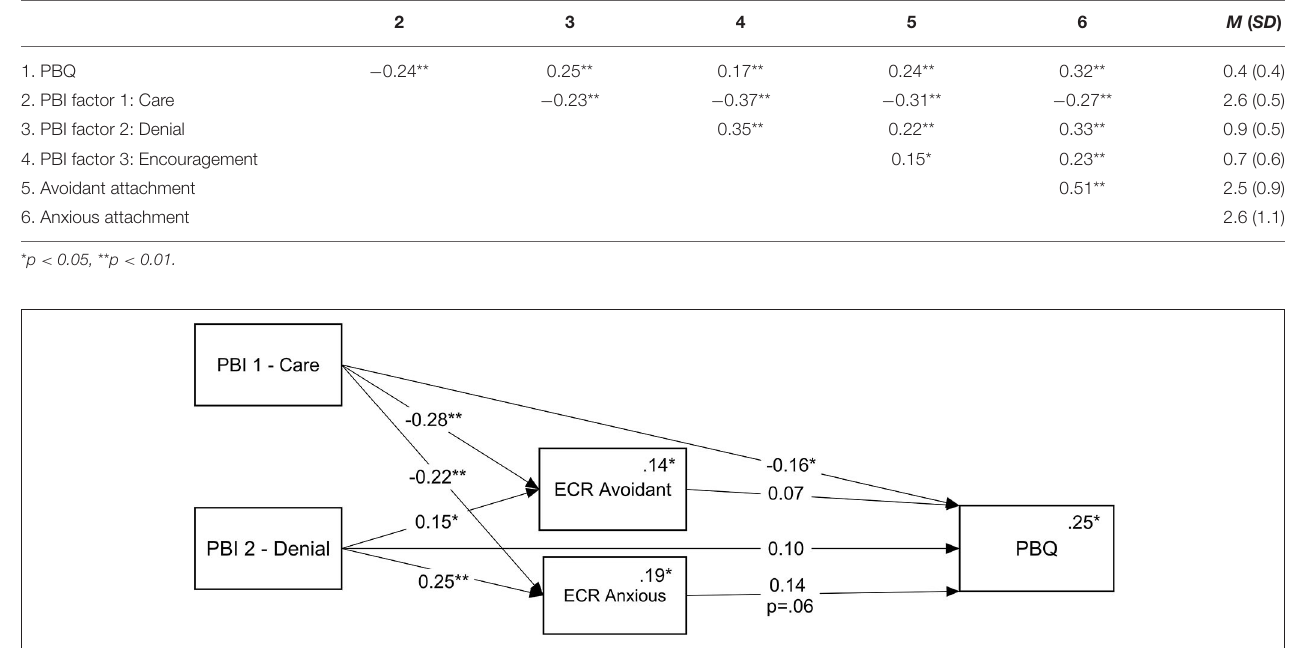
TABLE 3 | Descriptive statistics and Pearson correlations between the study variables.